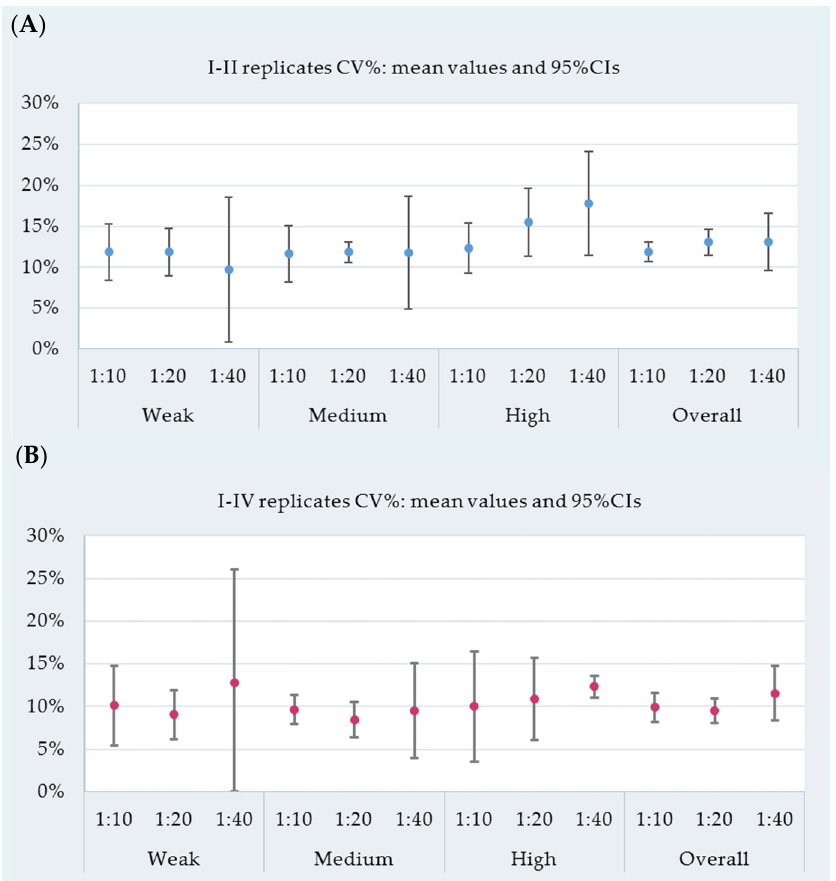
Figure 3. ( A ) Within-run coefficient of variability (CV%): mean value and 95% CI for each reactivity level and dilution. ( B ) Between-run coefficient of variability (CV%): mean value and 95% CI for each reactivity level and dilution ratio.